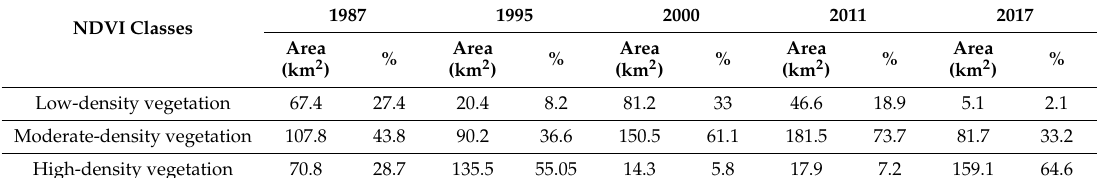
Table 6. Normalized difference vegetation index (NDVI) land cover change (in km 2 and percentage) from 1987 to 2017.